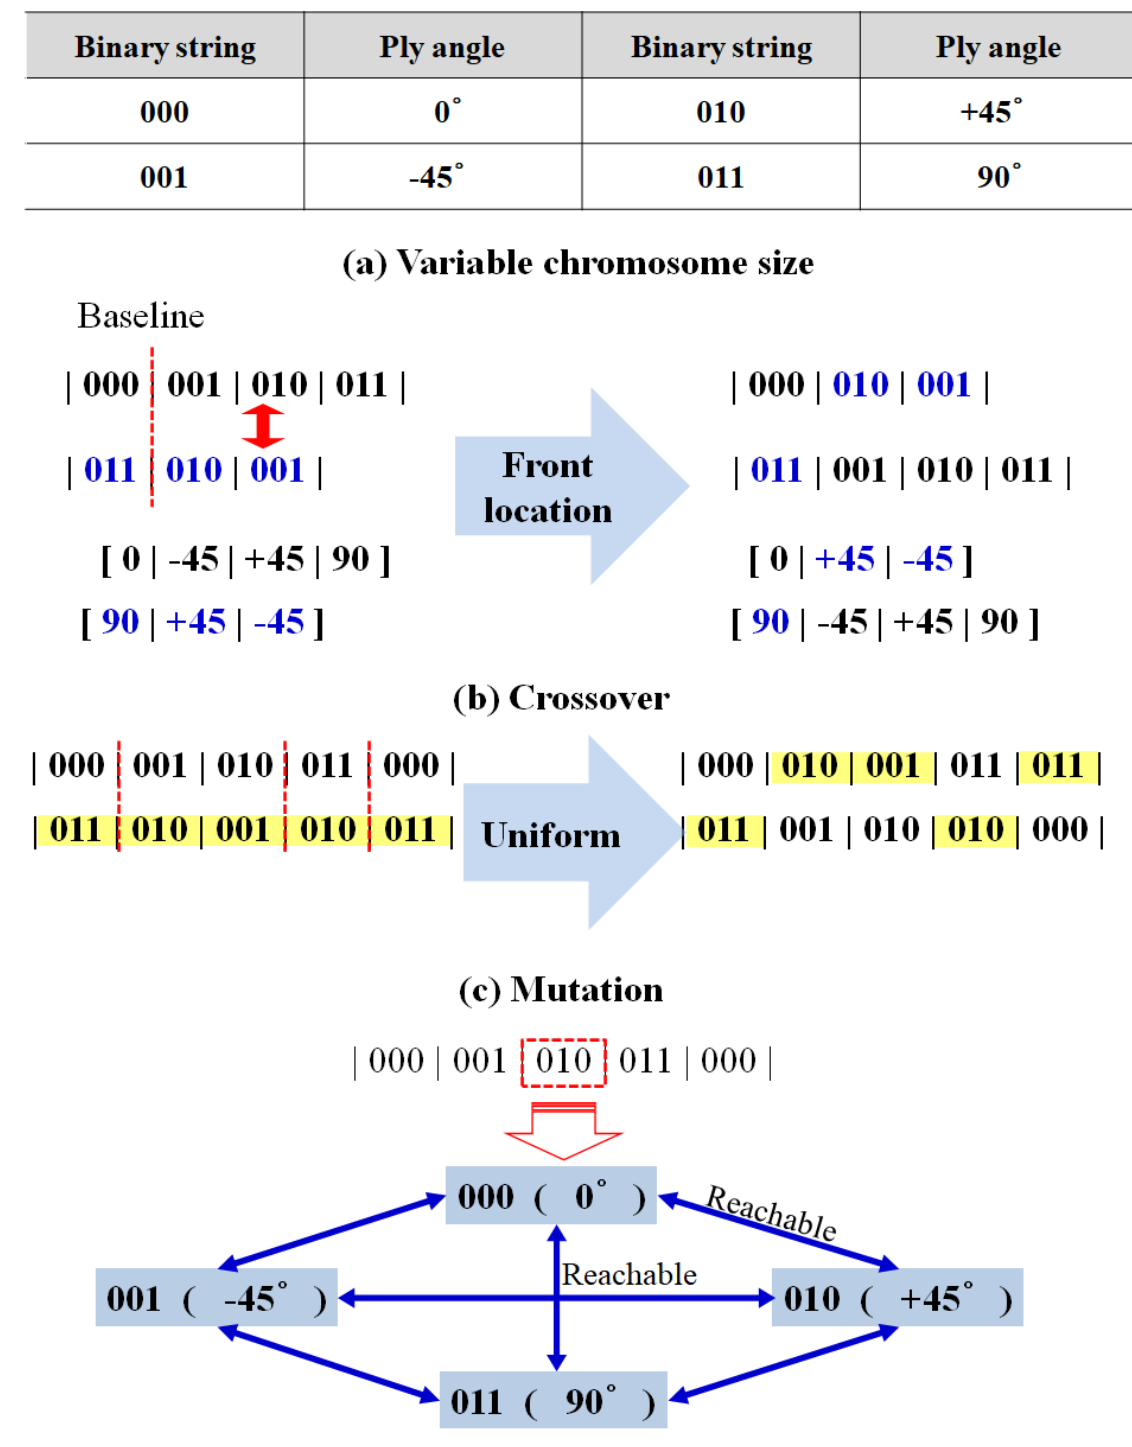
Figure 4. Progress of genetic algorithm of binary code according to composite material stacking and angle (chromosome, cross-over, mutation).